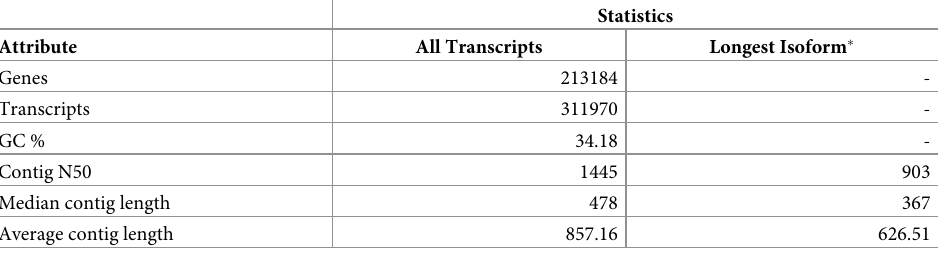
Table 1. Trinity transcriptome assembly quality